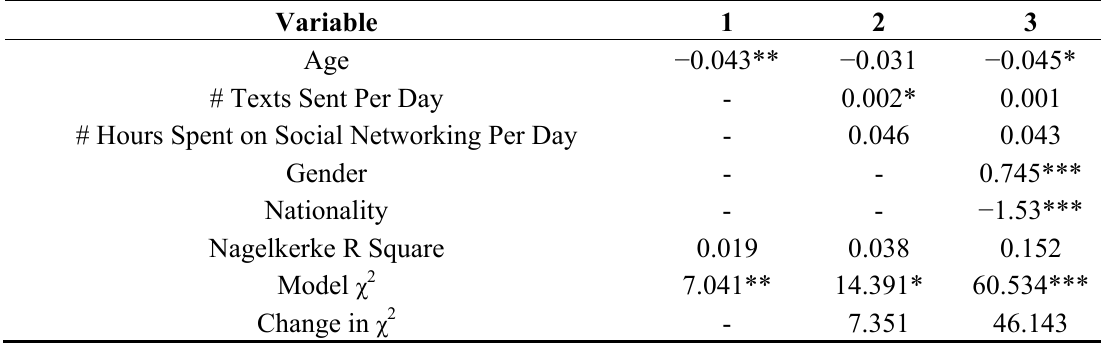
Table 5. Logit estimates of characteristics on socially interactive intimate violence (N =